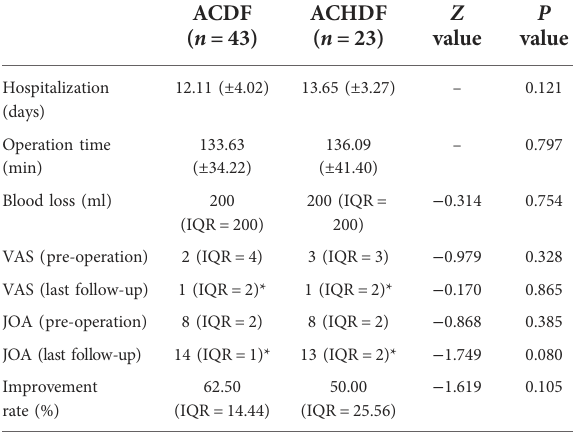
TABLE 3 The comparison of length of hospitalization (days), operation time (min), blood loss (ml), VAS, JOA score and improvement rate (%) of the two groups of ACDF and ACHDF.